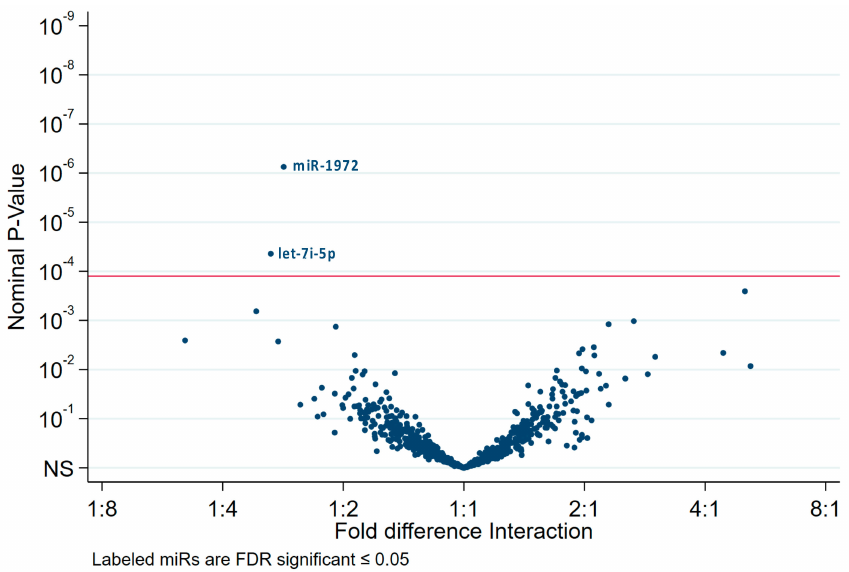
Figure 6. Interaction analysis of the di ff erentially expressed miRs presented as volcano